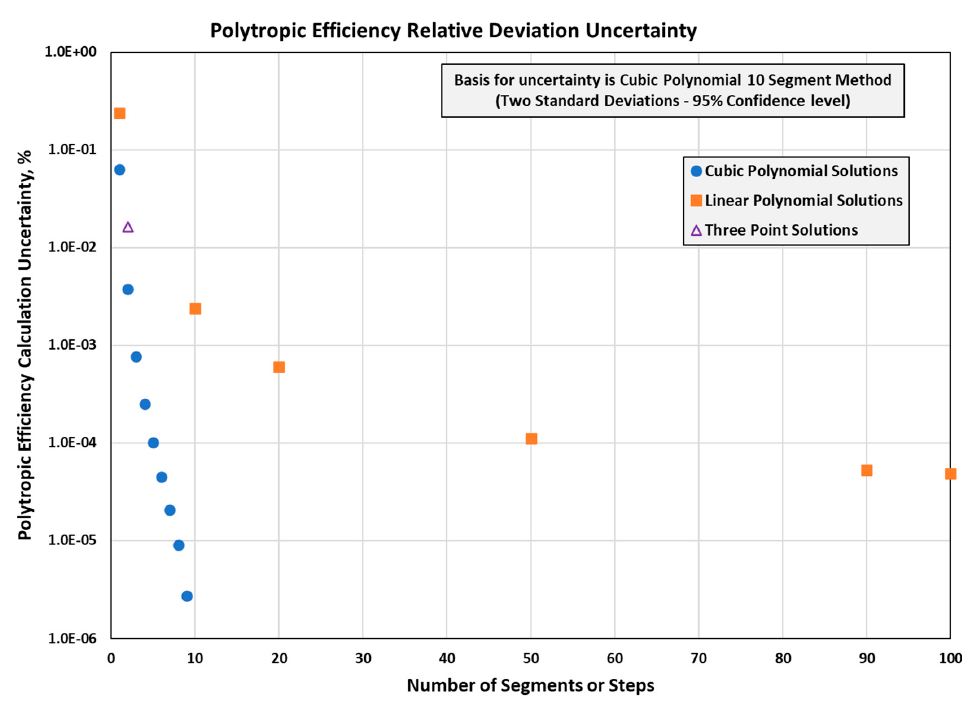
Figure A10. Calculation uncertainty comparison for 115 example cases.